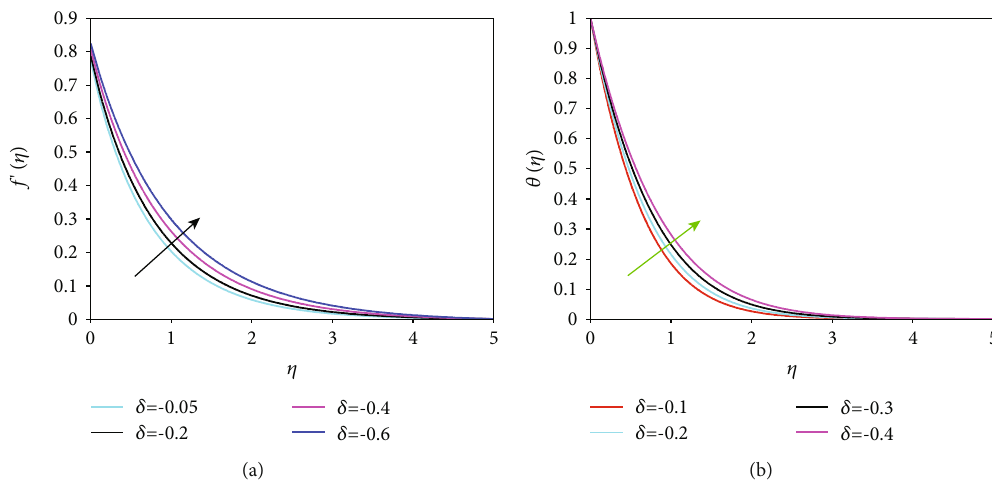
Figure 3: The graph of velocity and temperature for di ff erent values of injection ( − δ ).